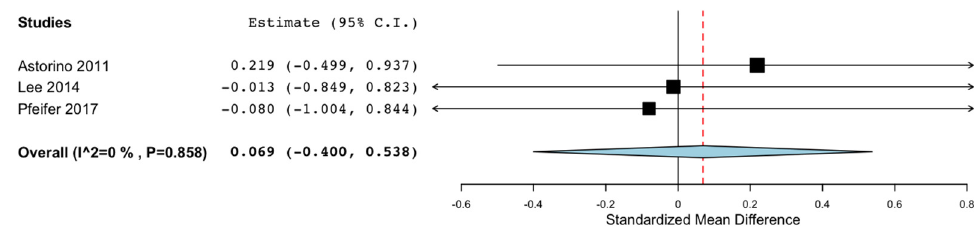
Figure 5. Effects of caffeine on agility after a fatigue protocol.